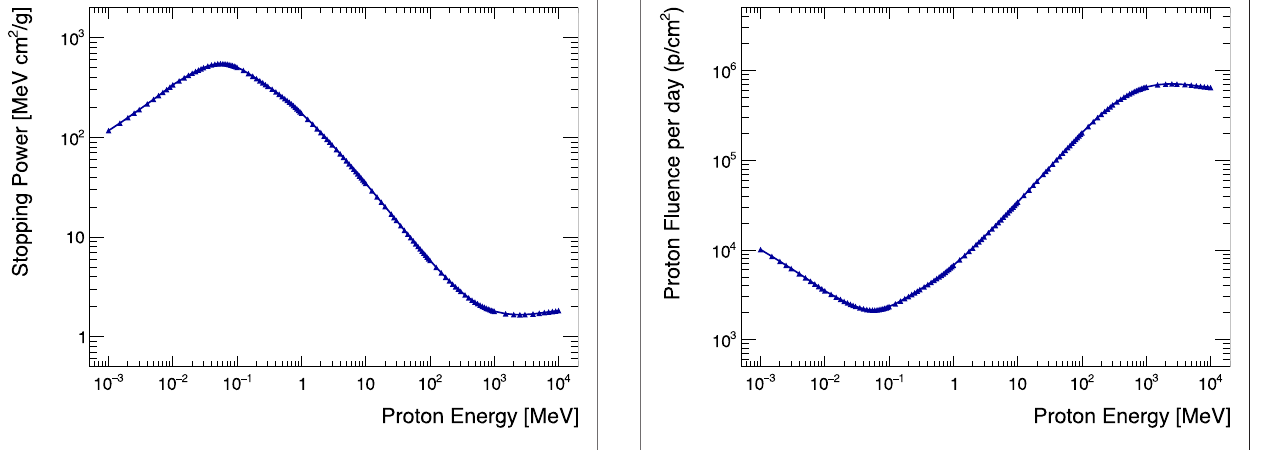
FIGURE 1 | Stopping power for protons applied to silicon, from Ref.